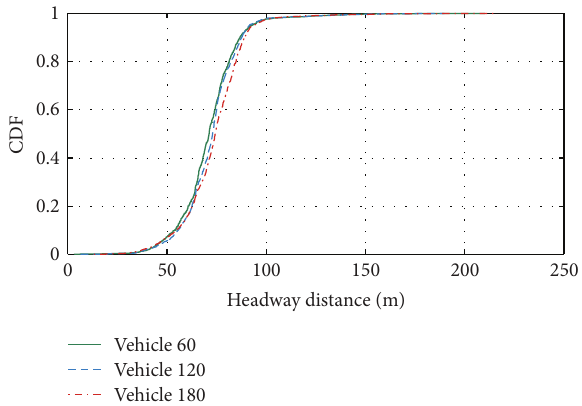
Figure 3: CDFs of the headway distances of vehicles at every second for total simulation time 𝑇 = 120 min.